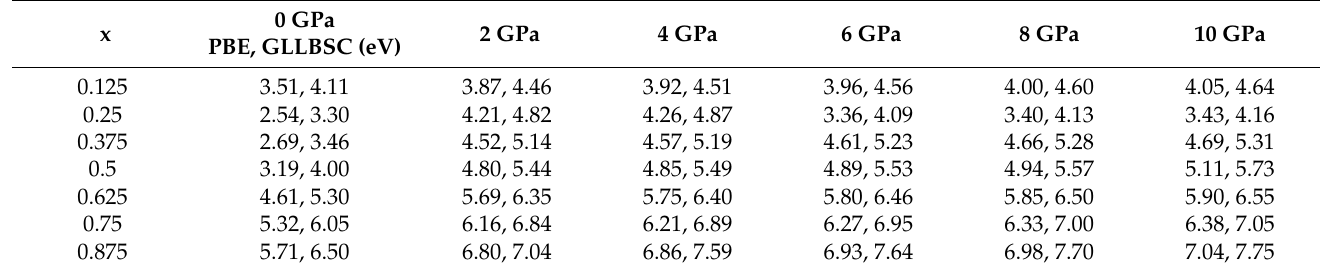
Table A2. Detailed band gap energy ( E g ) of 2 × 2 × 1 wurtzite Zn 1 − x Mg x O (WZ-ZMO1) for varied